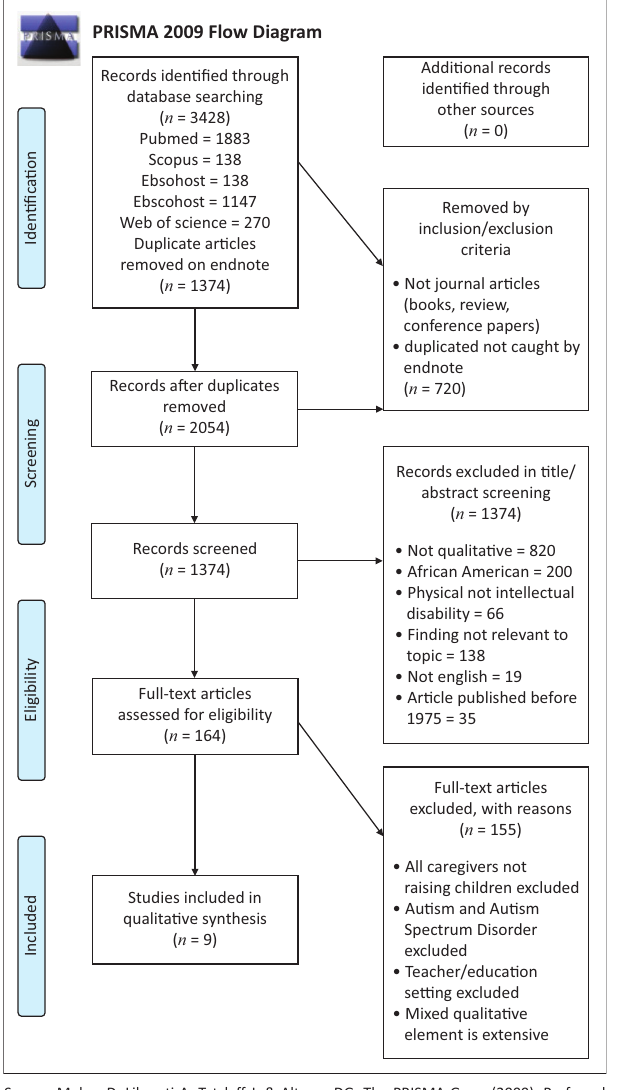
FIGURE 1: Prisma